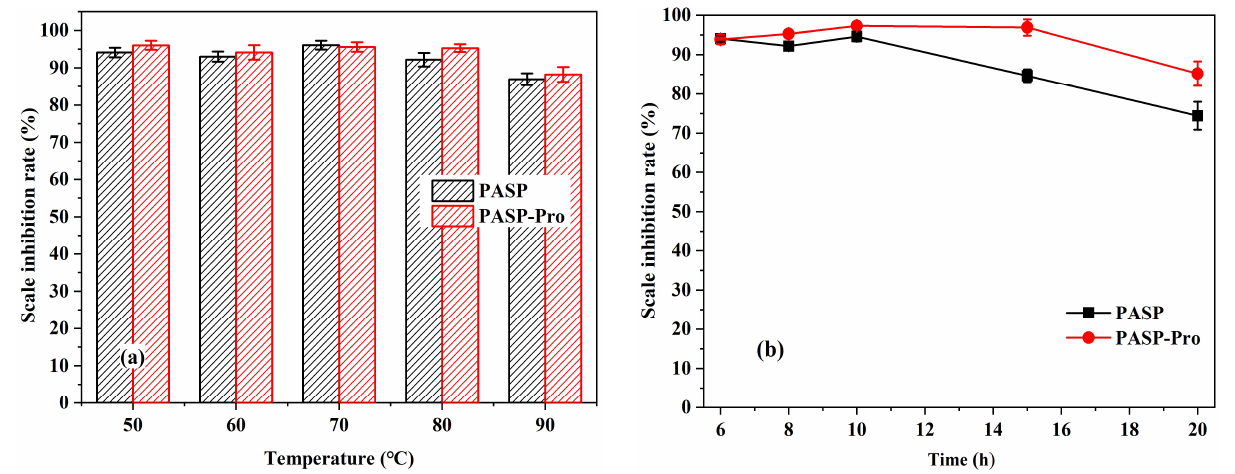
Figure 6. The effect of bath temperature ( a ) and bath time ( b ) on scale inhibition rate. The scale inhibition performance of PASP-Pro is much higher than that of PASP after